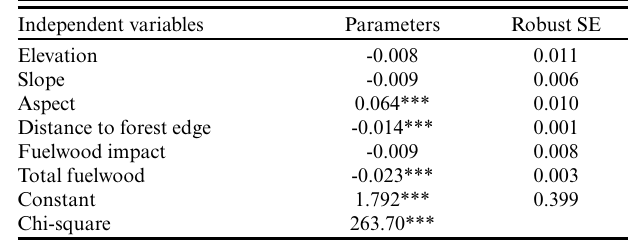
Table 4 . Pooled logit estimation of forest